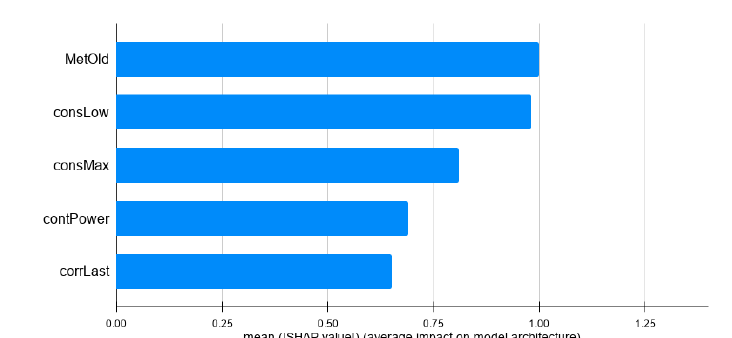
Figure 6. Mean absolute of SHAP values for the predictions of Campaign 1 using the Faults model. The top 5 contributing features are: MetOld (Antiquity of the meter), consLow (indicates the months passed since the customer consumed lower vs. the average consumption), ConsMax (maximum monthly consumption of the customer), ContPower (the contracted power) and CorrLast (months passed since last visit with no NTL).